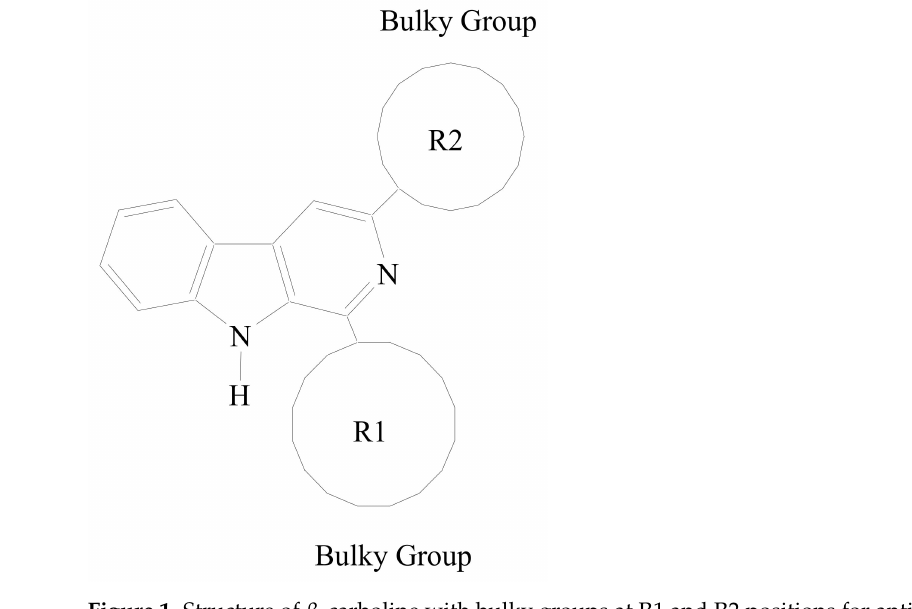
Figure 1. Structure of β -carboline with bulky groups at R1 and R2 positions for anticancer